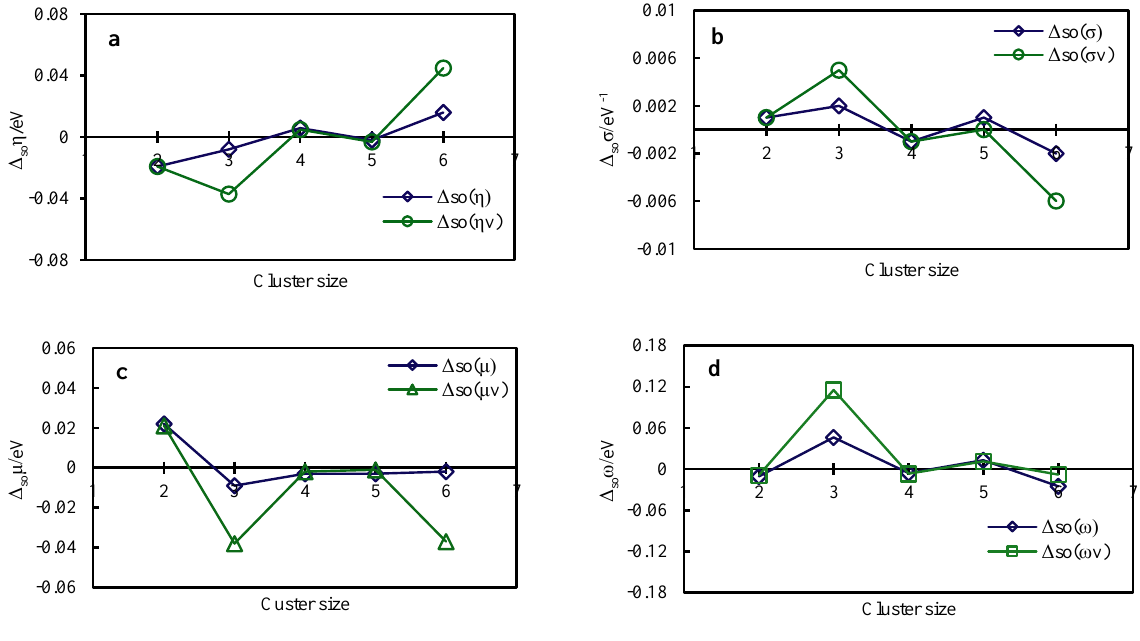
Figure 4. Spin-orbit corrections to the (a) chemical hardness, (b) softness, (c) chemical potential and (d) electrophilicity index. Subscripts ‘so’ and ‘v’ indicate ‘spin-orbit’ and ‘vertical’, respectively